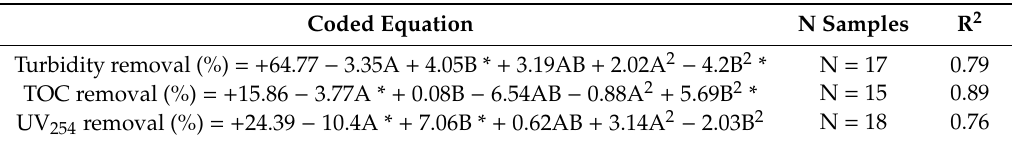
Table 4. Enhanced coagulation model fitting at the Montfull à DWTP.